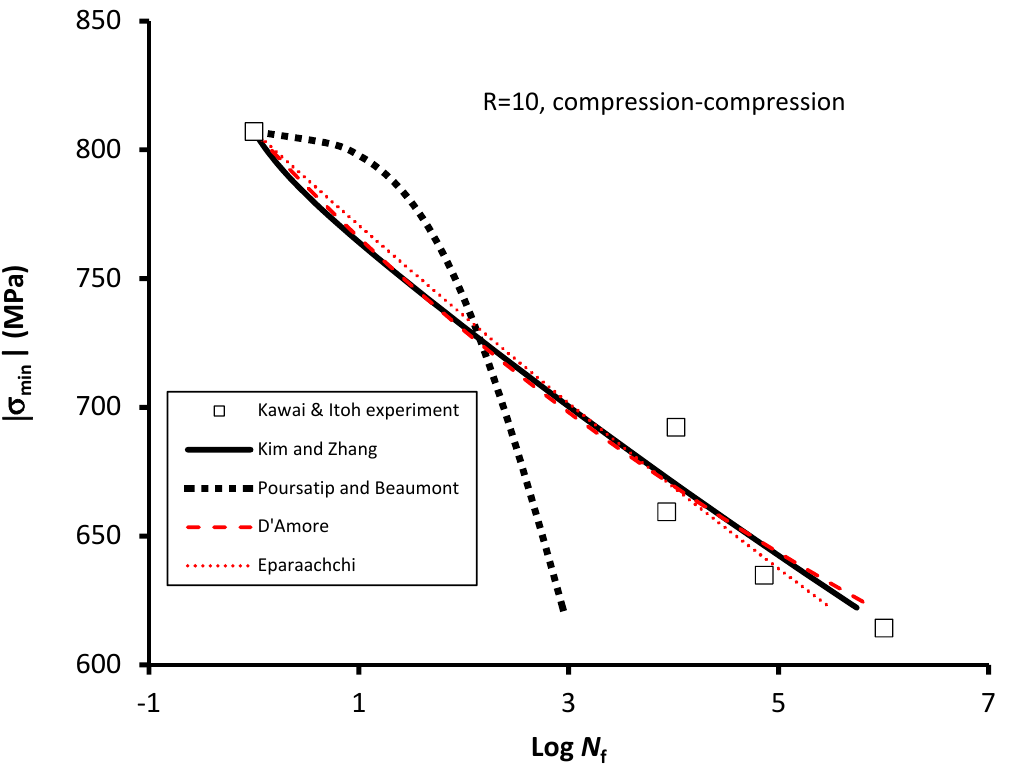
Figure 14. Kawai and Itoh experimental data at R = 10 [22] for carbon fiber reinforced epoxy laminates